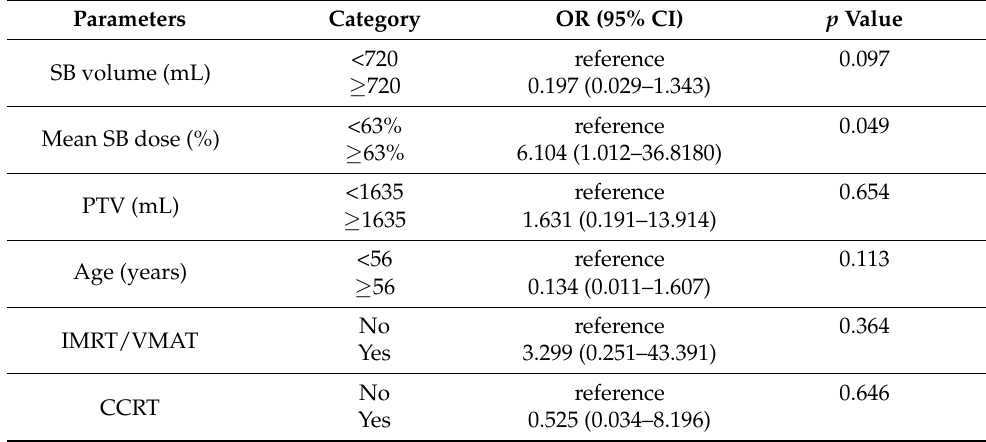
Table 3. Multivariate analyses of RIE.